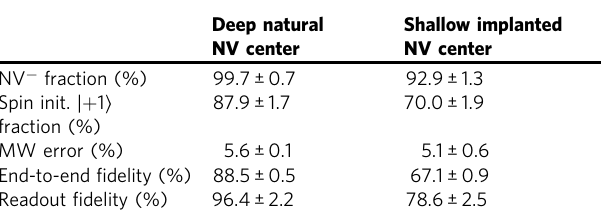
Table 1 Overview of the initialization and readout metrics for both NV centers presented in this